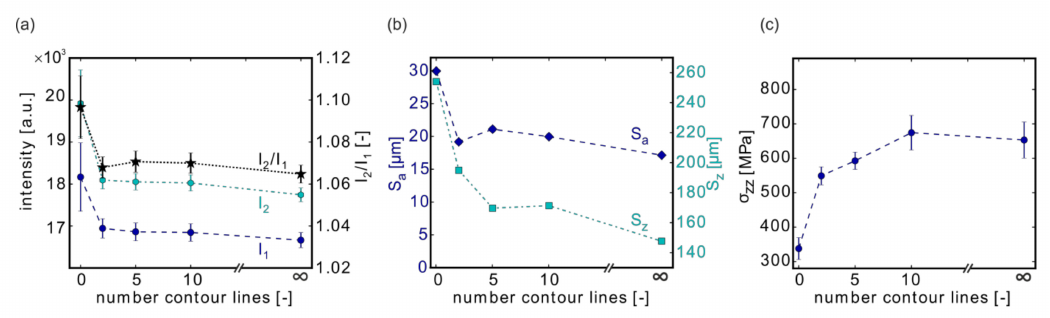
Figure 7. The influence of the contour line count on the MPM data ( a ), on the surface roughness ( b ), and on the residual stresses ( c ). Depicted are the results from samples #04 (only volume, no contour lines), #09 (2 contour lines), #05 (5 contour lines), #10 (10 contour lines), and #01 (only contour lines,